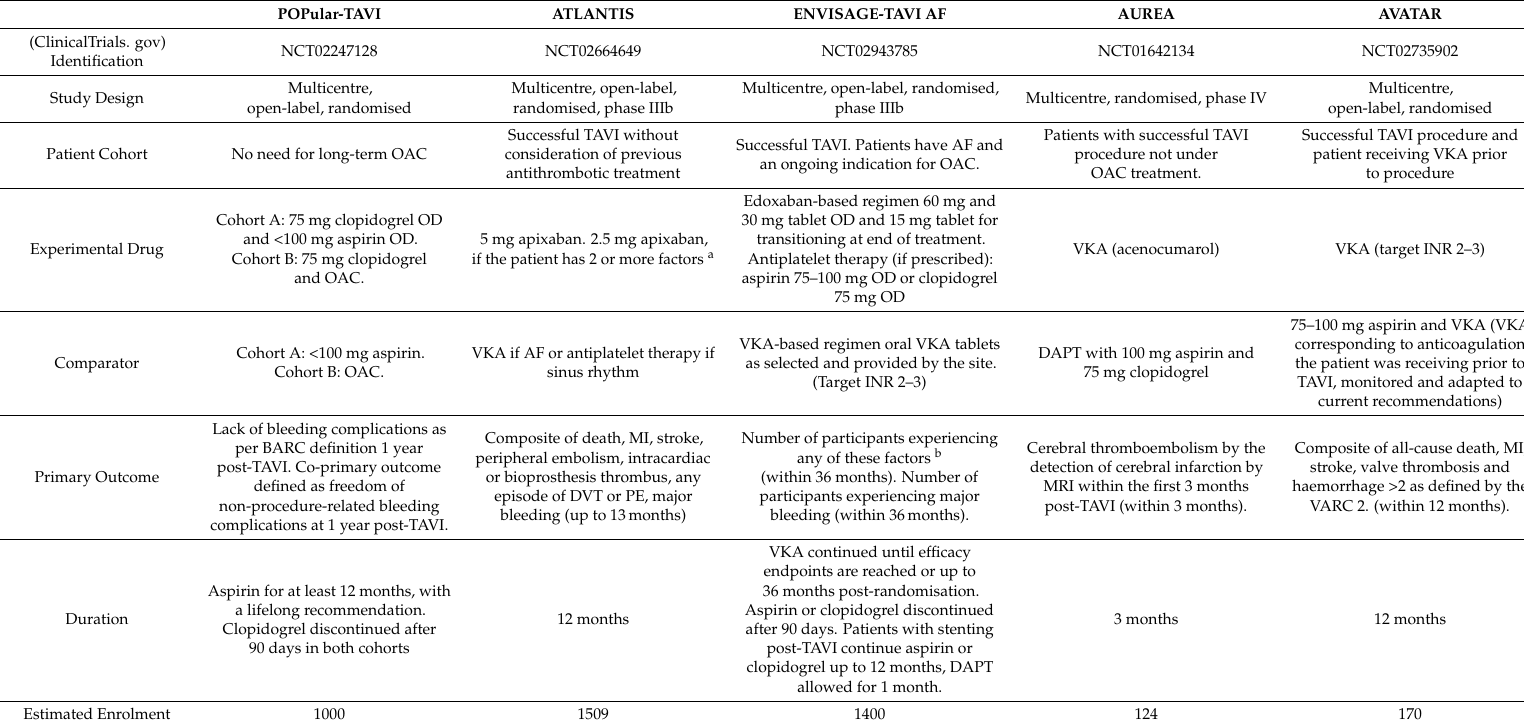
Table 3. Ongoing trials with novel oral anticoagulants in patients